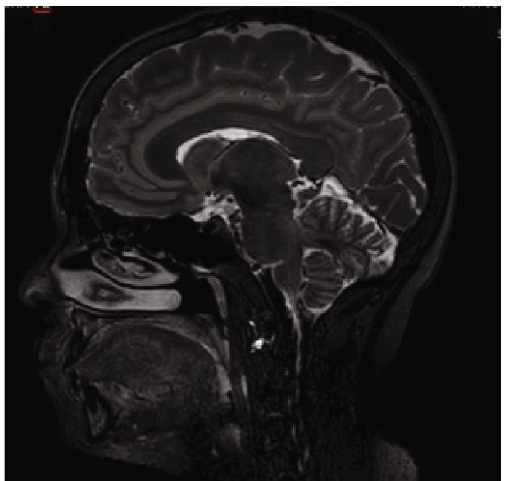
Figure 1: MRI of the pituitary gland, which is rather small for age and sex but without evidence of focal